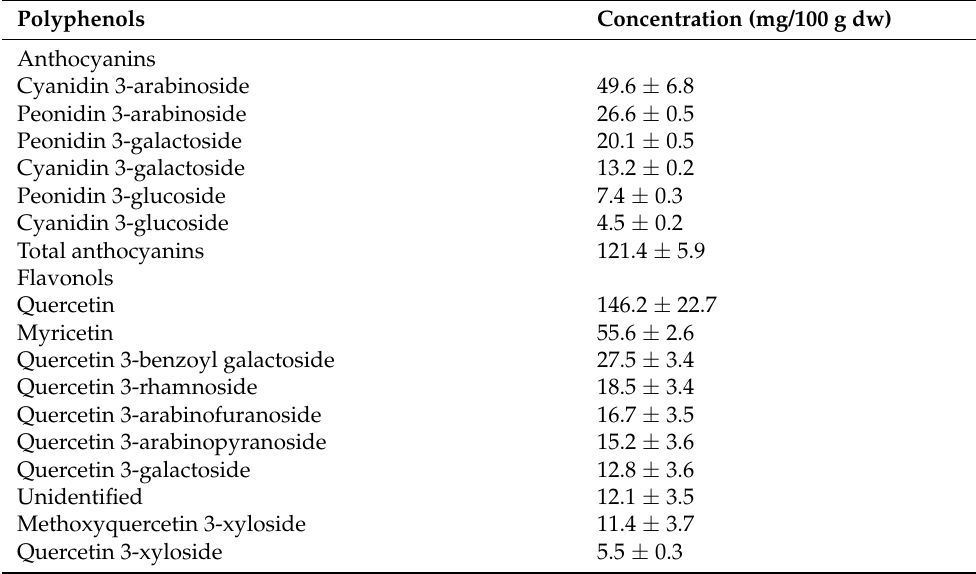
Figure 1. General processing steps and relative relationship for different cranberries materials (Adapted from Coleman et al. [7]). Table 2. Content of polyphenolic compounds in cranberry pomace (adapted from White et al. 2011